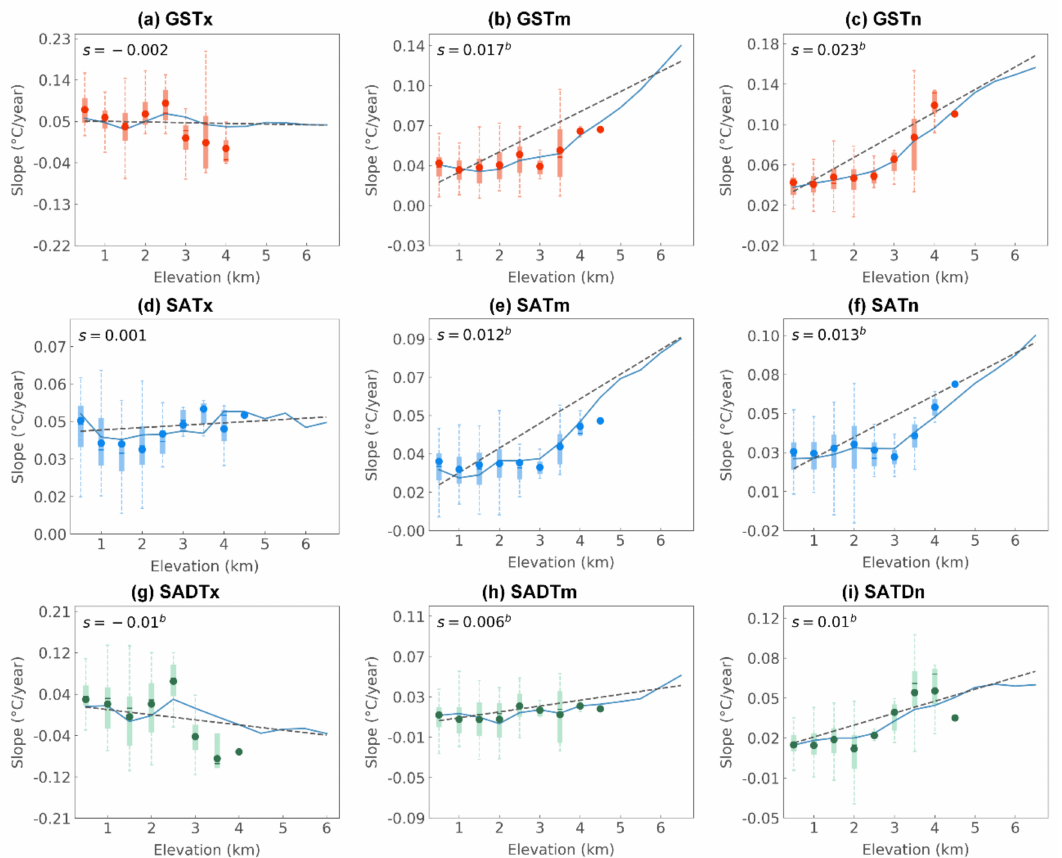
Figure 7. Variation rate of annual averaged ( a – c ) GST-, ( d – f ) SAT-, and ( g – i ) SATD-related indexes at each elevation bin in Southwest China from 1980 to 2019 (Box-and-whisker, where horizontal line and circle in box-and-whisker denote median and average, respectively, represents variation rate of observed meteorological stations at each elevation bin. Blue folded line represents mean variation rate of interpolated raster at each elevation bin. s denotes slope between annual variation rate of each index with